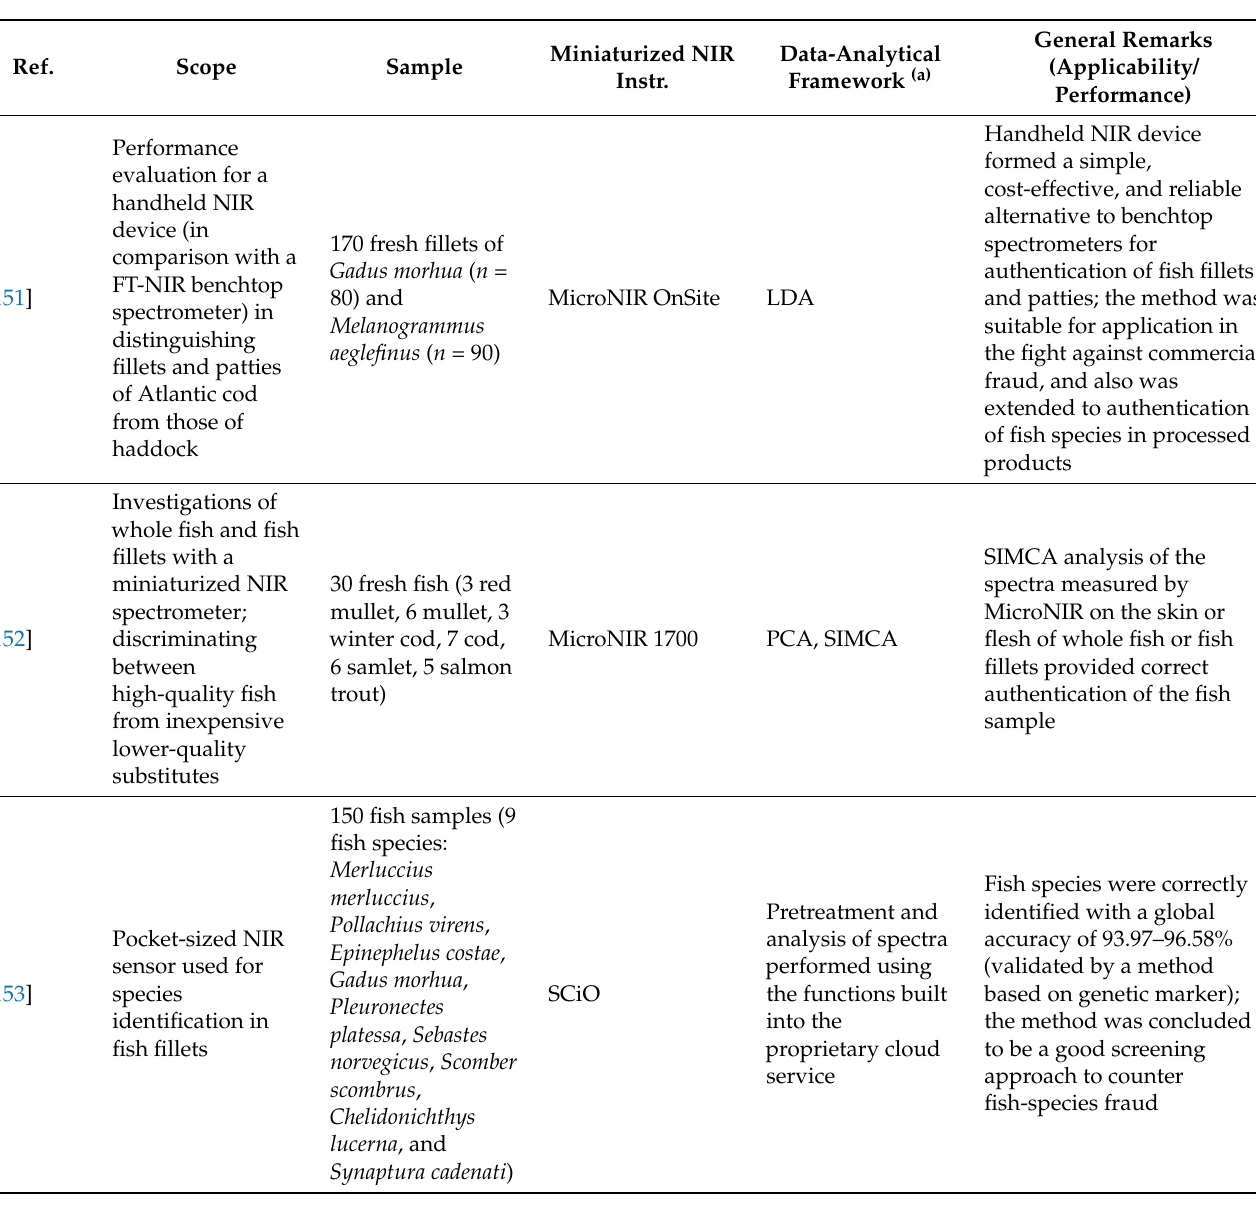
Table 6. Recent research activity oriented toward miniaturized NIR spectroscopy in the area of fish